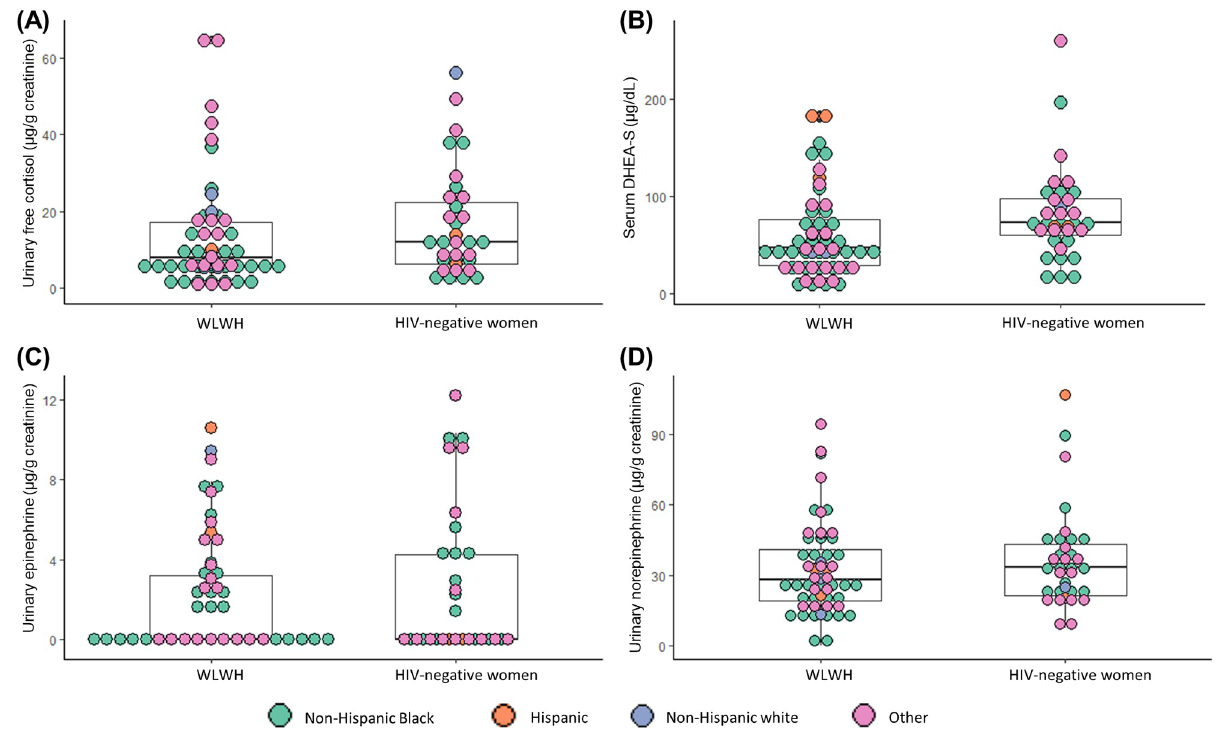
Fig 1. Dot and box plots of concentrations of (A) urinary free cortisol, (B) serum DHEA-S, (C) urinary epinephrine, and (D) urinary norepinephrine by HIV serostatus (n = 90). Laboratory test results below the lower limit of quantification were coded as 0 (n = 5 for urinary free cortisol, n = 52 for urinary epinephrine, and n = 1 for urinary norepinephrine). The central line, top border, and bottom border of box plots represent the median, 25th, and 75th percentiles, respectively, and the whiskers display 1.5 times the interquartile range. Abbreviations: DHEA-S, dehydroepiandrosterone sulfate; WLWH, women living with